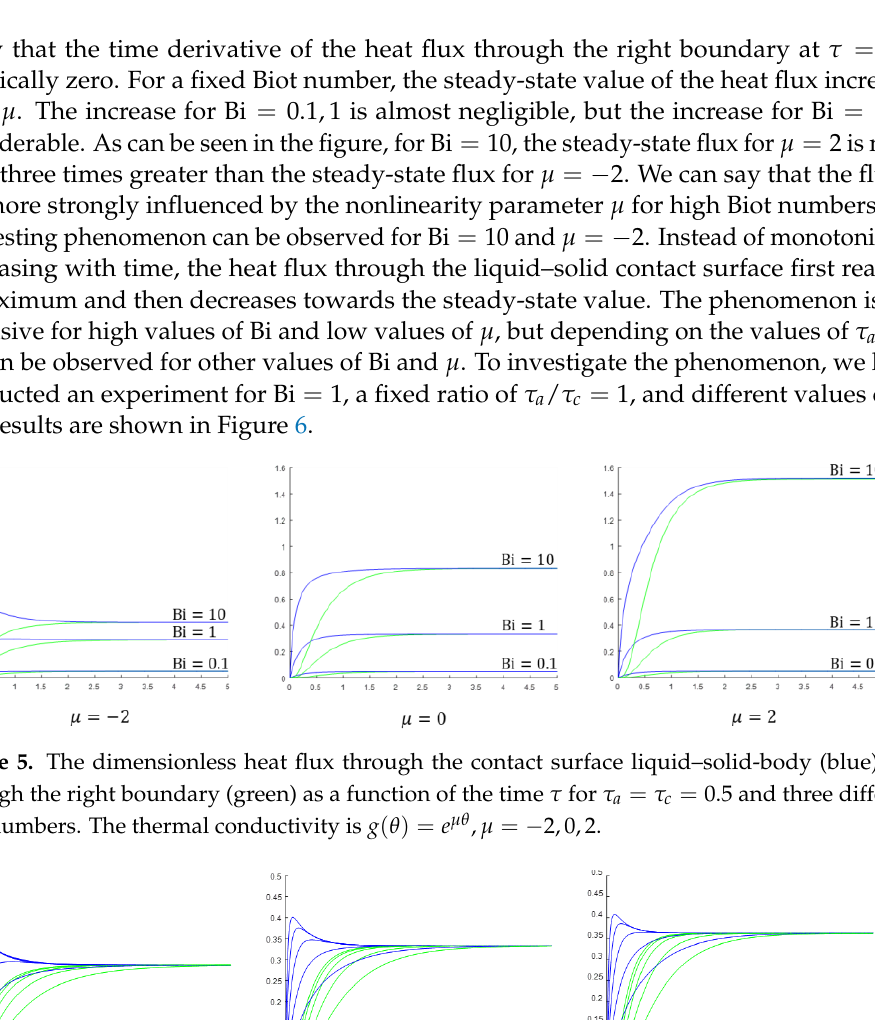
Figure 5. The dimensionless heat flux through the contact surface liquid–solid-body (blue) and through the right boundary (green) as a function of the time 𝜏 for 𝜏 𝑎 = 𝜏 𝑐 = 0.5 and three different